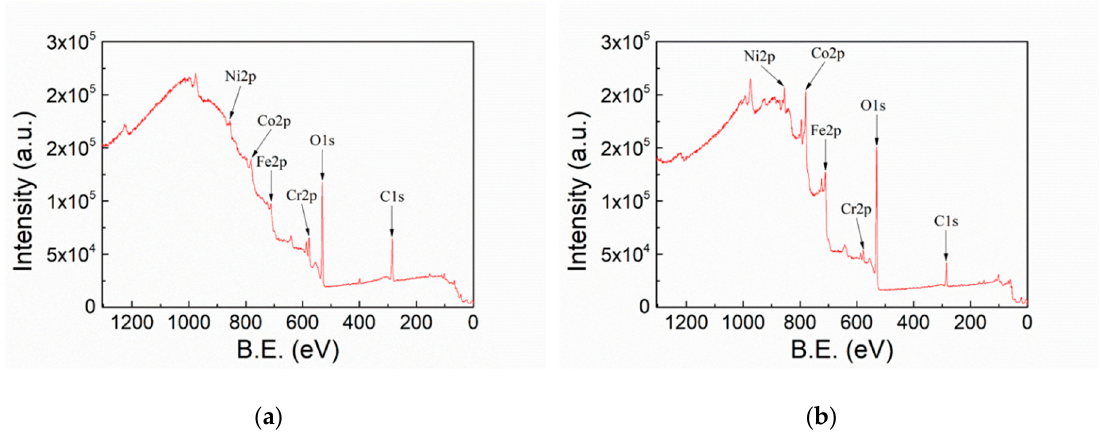
Figure 5. Bode magnitude and Bode phase plots of ( a ) bare MEA after 1 h, ( b ) APPJ-treated MEA after 1h, ( c ) bare MEA for 12 h, and ( d ) APPJ-treated MEA for 12 h.